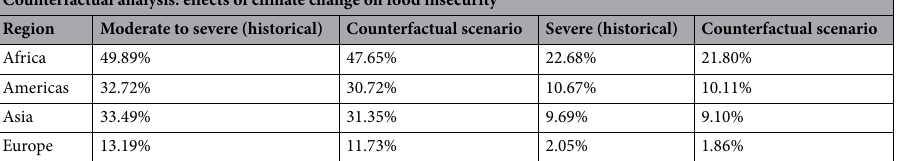
Table 4. Counterfactual analysis: effects of climate change on food insecurity.